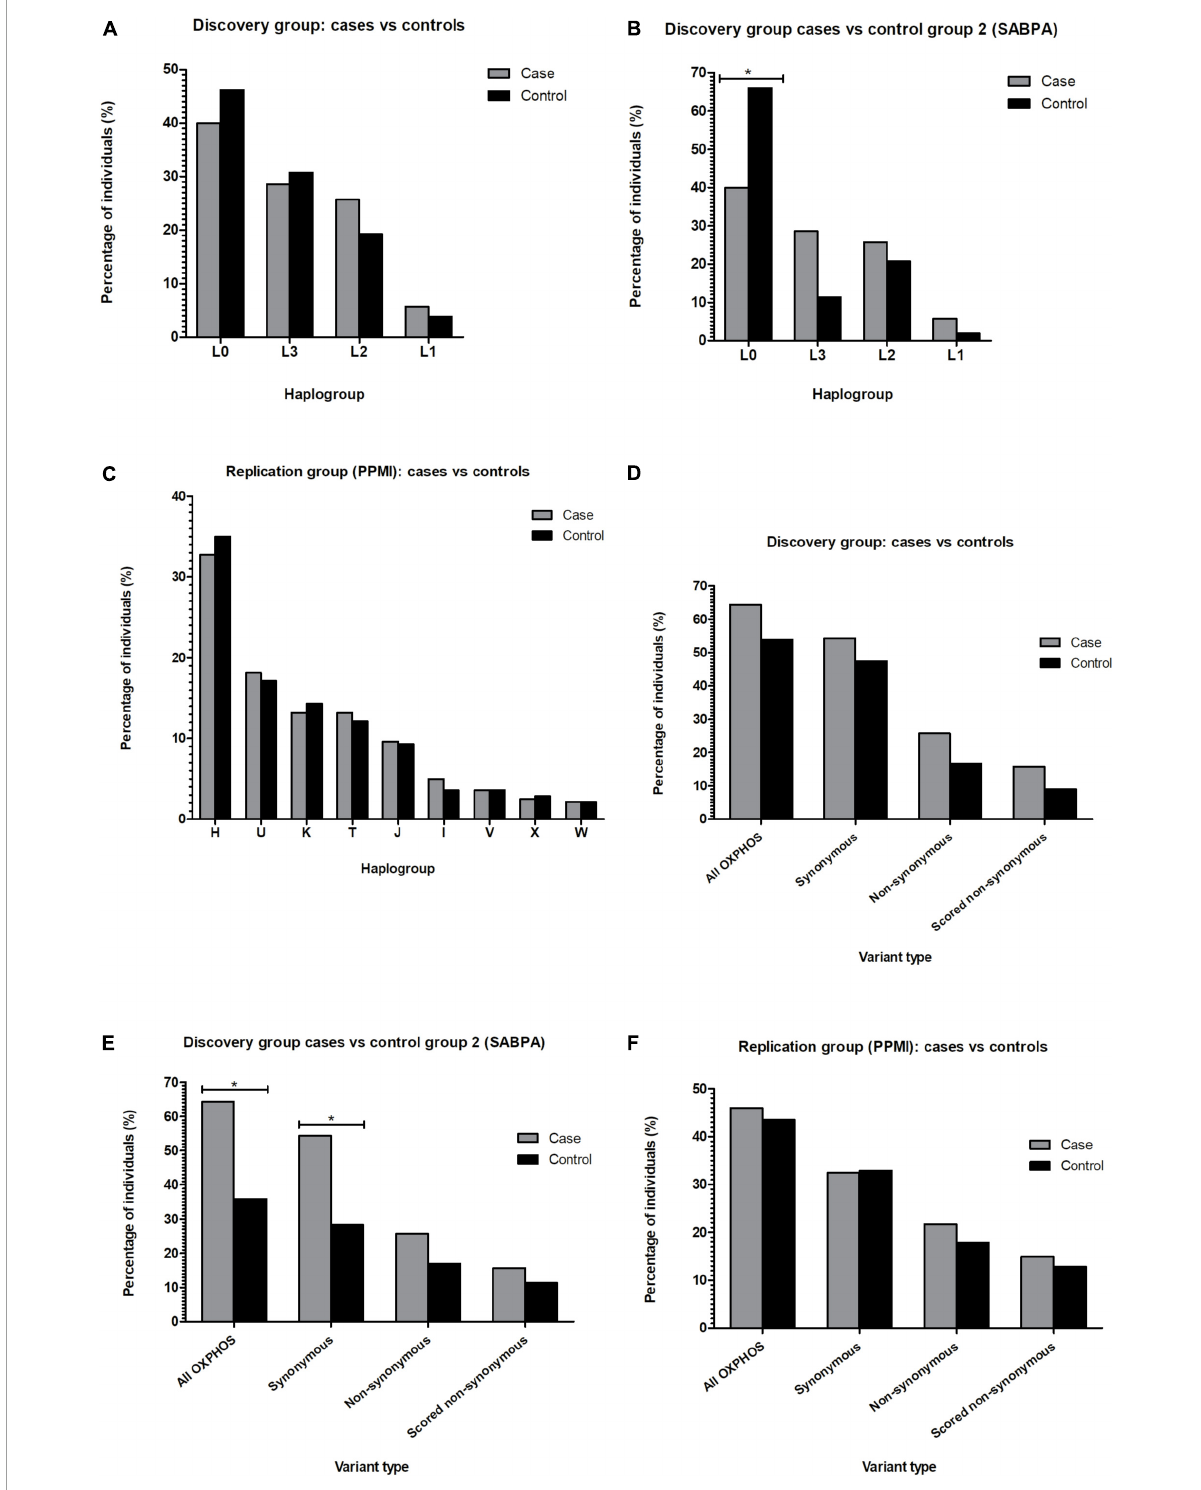
FIGURE3 Bar graphs showing the percentage of PD cases and controls from African (A,B) or European (C) maternal lineages identified in the study, as well as the percentage of PD cases vs. controls carrying out-of-place mtDNA variants ( D – F ). * P < 0.0125. mtDNA, mitochondrial DNA; OXPHOS, oxidative phosphorylation; PPMI, Parkinson’s Progression Markers Initiative; SABPA, Sympathetic activity and Ambulatory Blood Pressure in Africans